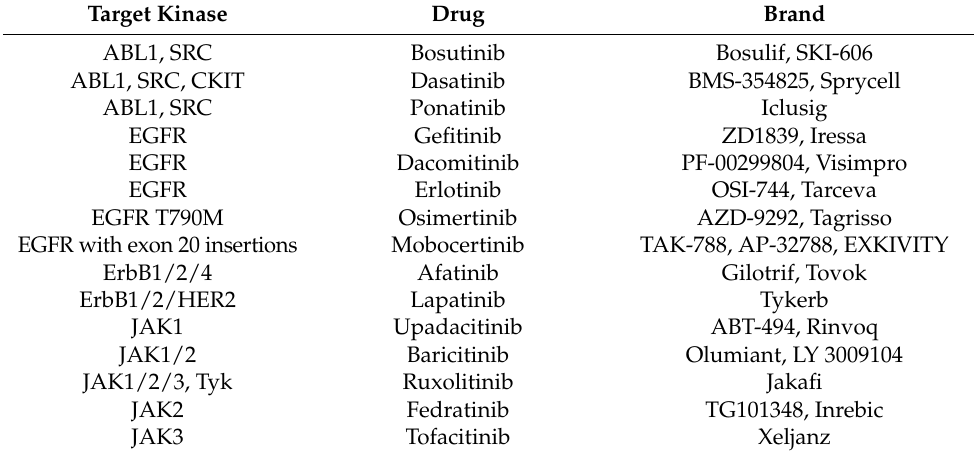
Table 1. FDA-Approved Inhibitors of ERBB1/EGFR, SRC, and